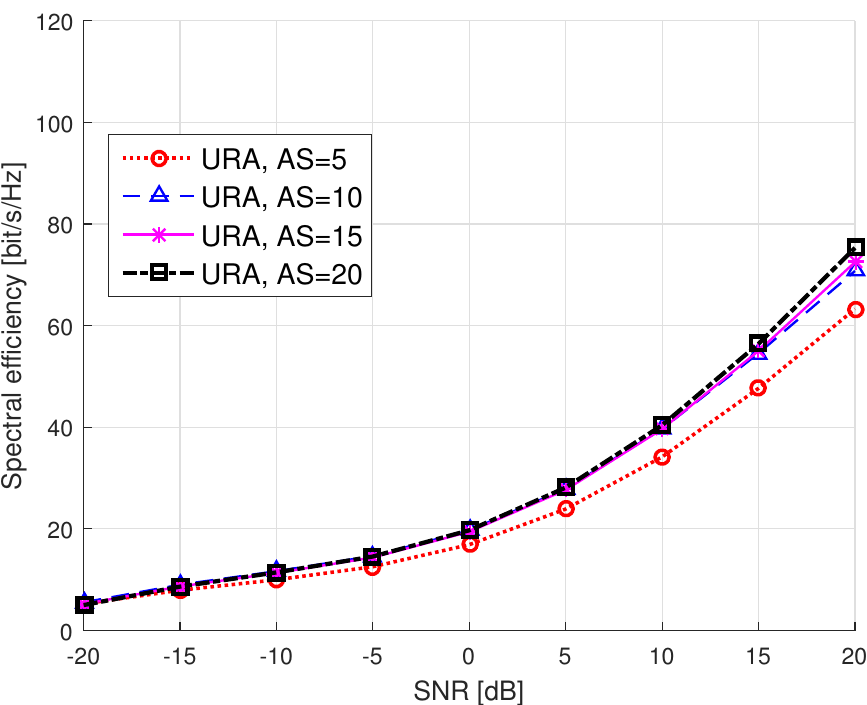
Figure 11. Spectral efficiency vs. SNR in dB for the URA topology, U = 10 UEs, M = 128, with different values of angular spread α A ( AS )